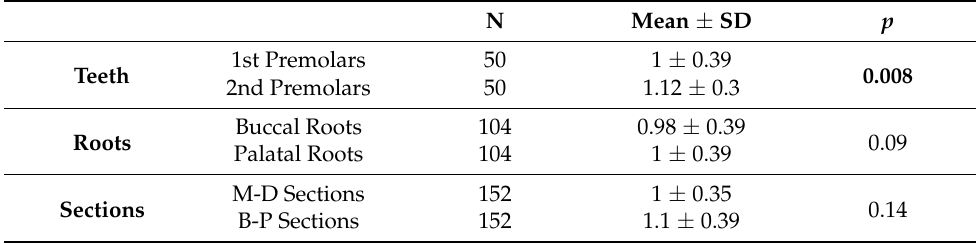
Table 1. Frequency of measurements, means, and standard deviations of each measurement. Inde- pendent two sample t -tests were performed to compare measurements between teeth (1st premolars vs. 2nd premolars), roots of monorradicular premolars (buccal vs. palatal), and sections (mesio-distal vs. bucco-palatal). Statistically significant differences are in bold